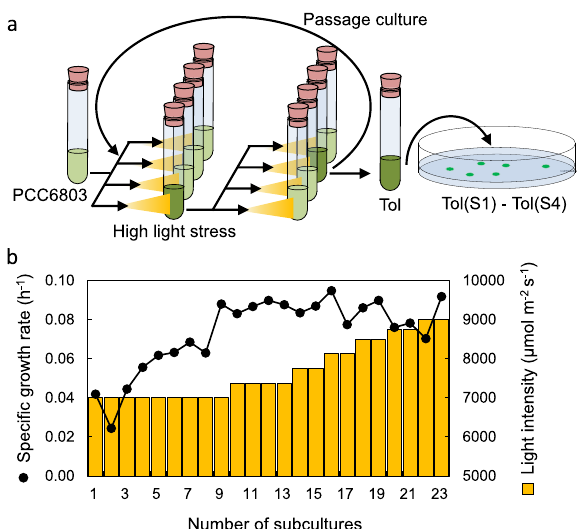
Fig. 2 ALE experiment under high light stress condition. a Experimental design of the ALE experiment. Cells were cultured in a test tube using a point source LED. Among four parallel cultures, the culture broth with the highest growth rate was inoculated into a fresh medium every 2 – 3 days. b Changes in speci fi c growth rate during ALE experiment. Line plot indicates speci fi c growth rate and bars indicate light intensity at each subculture experiment.